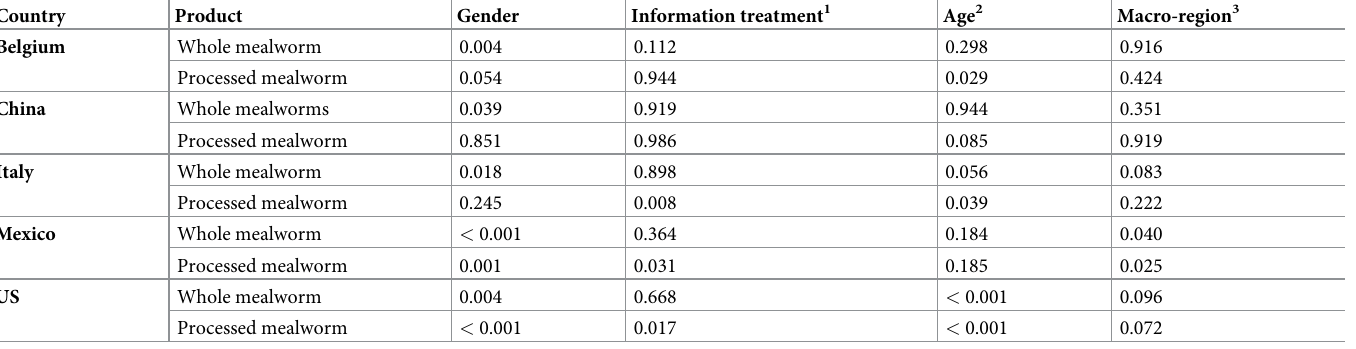
Table 2. Effect ( P value) of gender, information treatment, age, and macro-region on acceptance of the inclusion of mealworms (whole or processed) in the consum- ers’ diet in Belgium, China, Italy, Mexico, and the